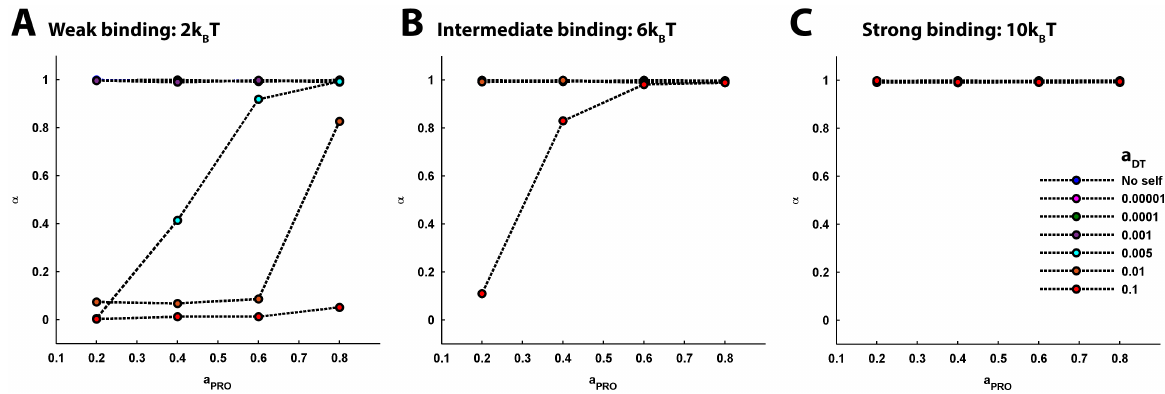
Fig 7. The effect of varying DT-PRO binding energy and PRO density on the anomalousity of tracer diffusion, under different self-crowding conditions. (A) Weak DT-PRO binding. The profiles of variation in anomalous exponent, α , of the tracer diffusion under the different conditions of self-crowding are plotted together across the increasing a PRO . α remains equal to one across the entire span of a PRO for the no-self-crowding condition and the self-crowding conditions with a DT (cid:20) 0.001. For a DT = 0.005, α gradually rises from zero and approaches 1 with increase in a PRO . However, the rise in α becomes significantly slower for the higher a = 0.01, such that it remains less than 1 even at a = 0.8. In continuation, DT PRO for very high a DT = 0.1, effect of increasing a PRO is visibly insignificant and α remains close to zero. (B) Intermediate DT-PRO binding. α remains 1 across the entire span of a for the no-self-crowding condition and the self-crowding conditions with a (cid:20) 0.01. It is only for a = 0.1 that, PRO DT DT with increase in a PRO , α sharply rises and approaches 1 by a PRO = 0.6. (C) Strong DT-PRO binding. α remains 1 across the entire span of a PRO for the no-self-crowding condition as well as all values of a . (A-C) It is evident that increase in binding reduces anomalousity of tracer diffusion DT arising from self-crowding. However, the intensity of a PRO -dependent amelioration of anomalousity further depends on the intensity of self- crowding.